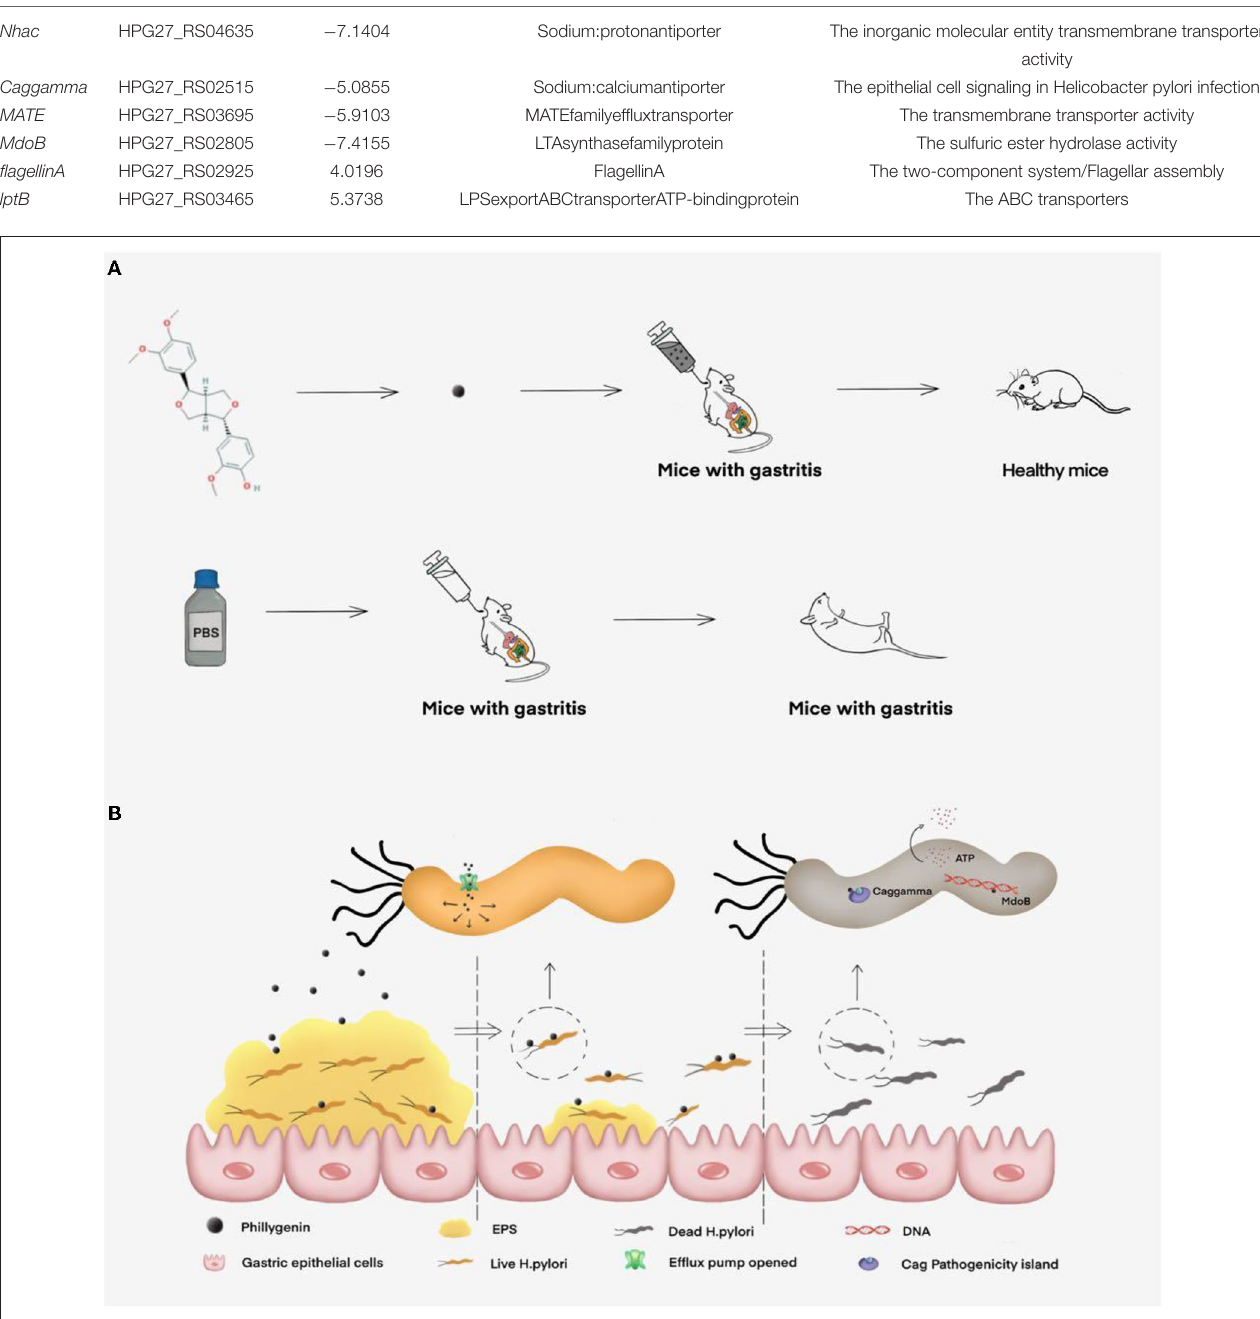
FIGURE 8 | The inhibitory effect of phillygenin on H. pylori and its mechanism map. (A) The therapeutic effect of phillygenin on H. pylori -infected acute gastritis in mice and (B) the mechanism of phillygenin, mainly including inhibiting biofilm formation, causing ATP leakage, weakening H. pylori ’s virulence,